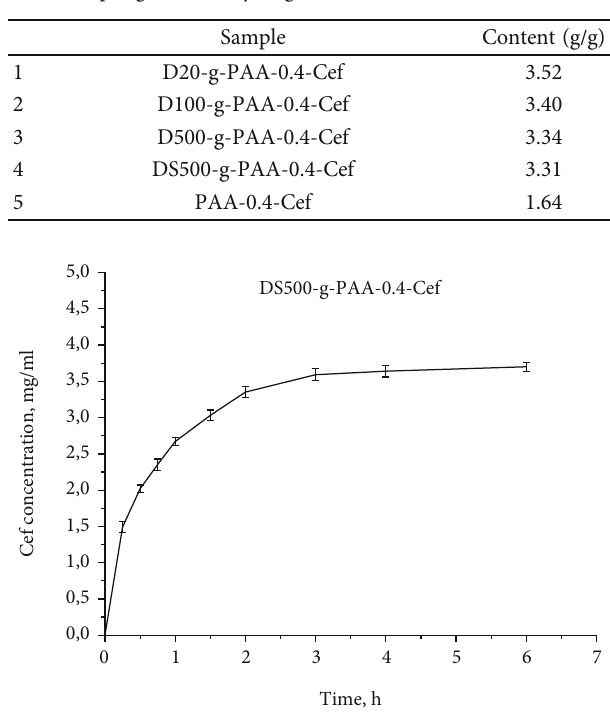
Table 2: Content of cefuroxime in the synthesized hydrogels (g of antibiotic per g of dried hydrogel).